Question: In one sentence, what is this figure communicating?
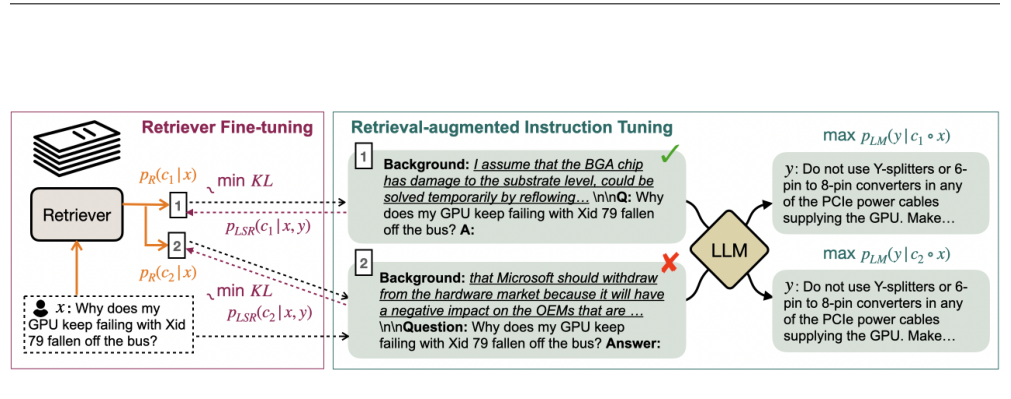
Answer: The RA-DIT approach separately fine-tunes the LLM and the retriever. For a given exam- ple, the LM-ft component updates the LLM to maximize the likelihood of the correct answer given the retrieval-augmented instructions (§2.3); the R-ft component updates the retriever to minimize the KL-Divergence between the retriever score distribution and the LLM preference (§2.4)